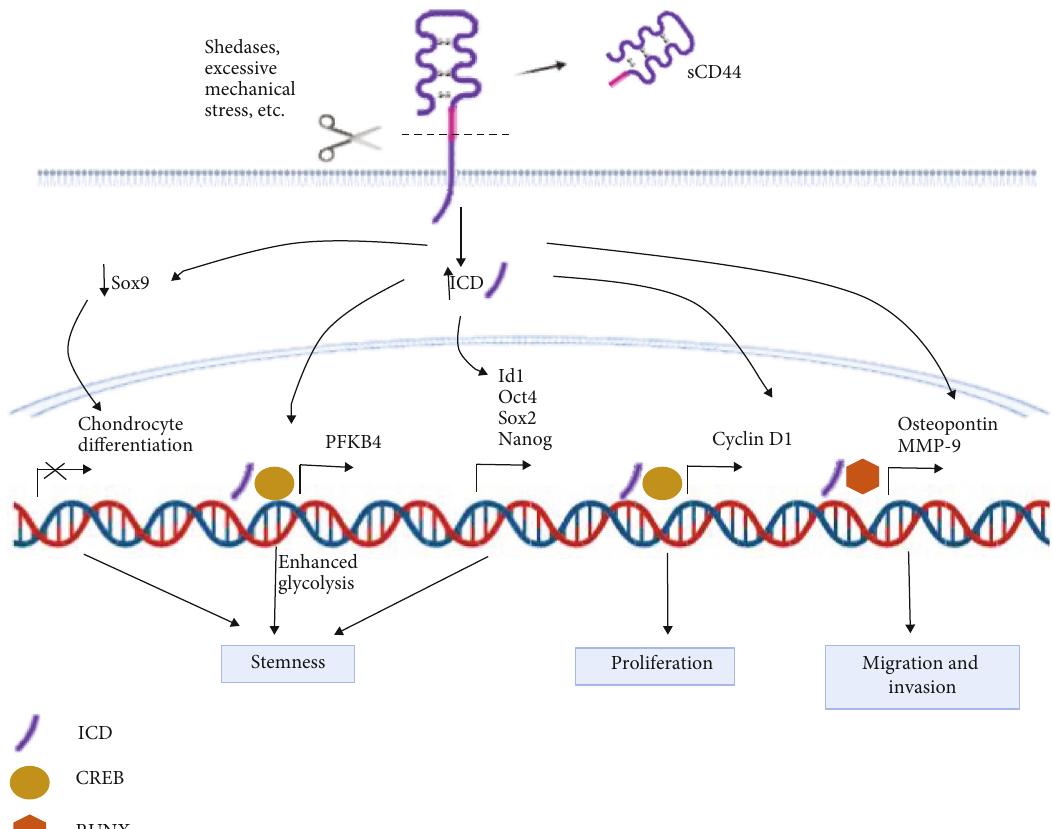
Figure 3: Genes activated or inhibited by the CD44 intracellular domain as reported in several epithelial cancer cells (prostate, thyroids, chondrocytes, and